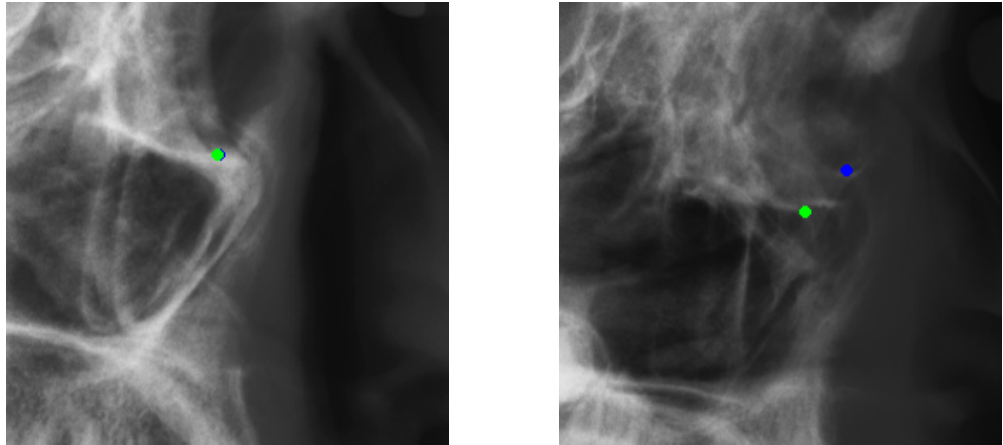
Figure 10. Successful detection example from Testset1 and failed detection example from Testset2 on Landmark 3. Green points: predicted result. Blue points: ground-truth